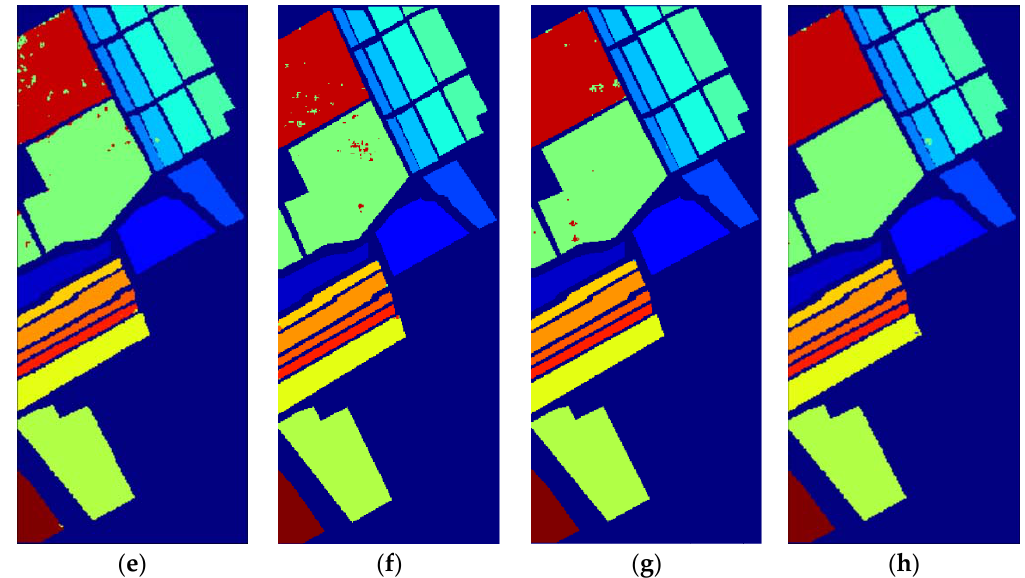
Figure 13. Classification maps for the Salinas scene data set. ( a ) Ground truth. ( b ) SVM. ( c ) 3D-CNN. ( d ) ResNet. ( e ) SSRN. ( f ) DFFN. ( g ) MPRN. ( h ) MSSN.